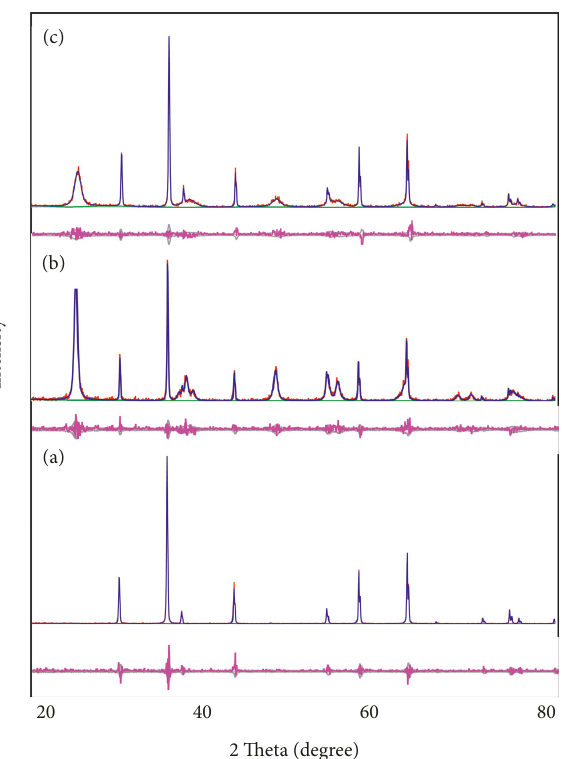
Figure 2: Rietveld image of (a) NiFe 2 O 4 , (b) NiFe 2 O 4 @TiO 2 , and (c) NiFe 2 O 4 @TiO 2 @rGO core@shell